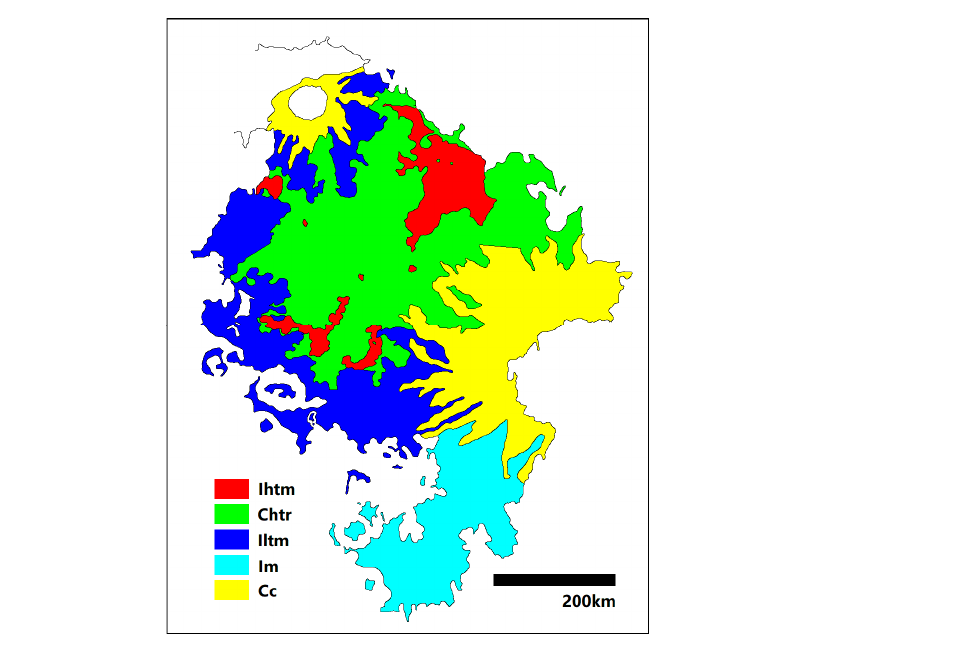
Figure 3. Ihtm, Chtr, Iltm and Im can be considered as four phases of mare basalt. Cc is the ejecta of the craters, such as the Langrenus Crater and the Taruntius Crater, over the basalt units. Unlike other mare basins, Mare Fecunditatis is a ff ected by a large crater— Langrenus. The ejecta of Langrenus spreads over the east part of Mare Fecunditatis and covers the mare basalt. In other words, this part combines crater ejecta and mare basalt.